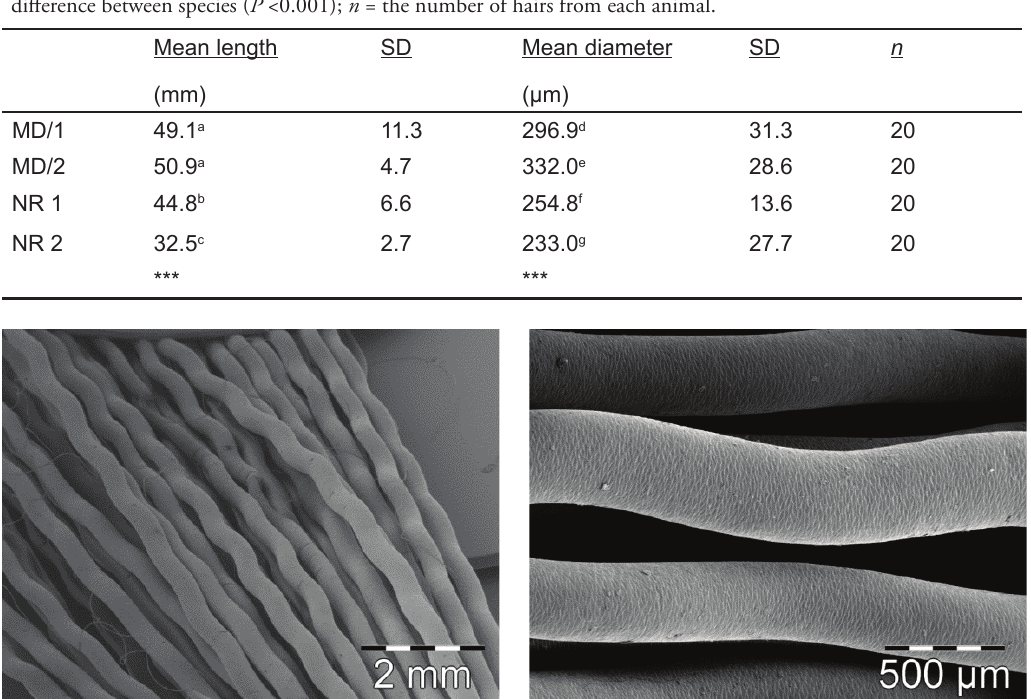
Figure 4. SEM images of guard hairs from the back of the winter pelage of musk deer. Left: the intact pelage showing the dense packing of wavy hairs and just a few strands of underfur (bottom left corner). Right: two hairs at higher magnification showing the ’scaly‘ surface structure of the